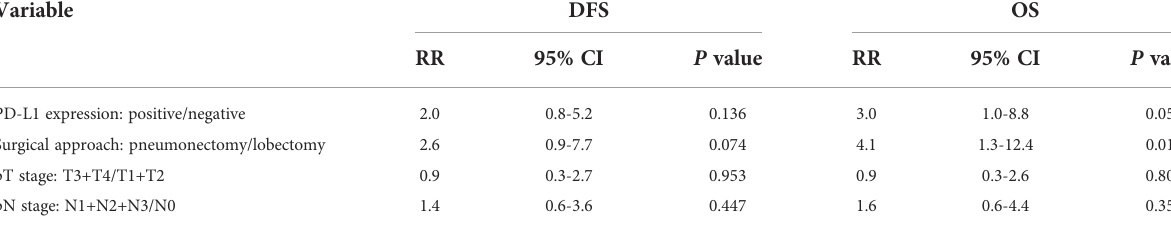
TABLE 7 Multivariate analysis of DFS and OS in patients with PSC.